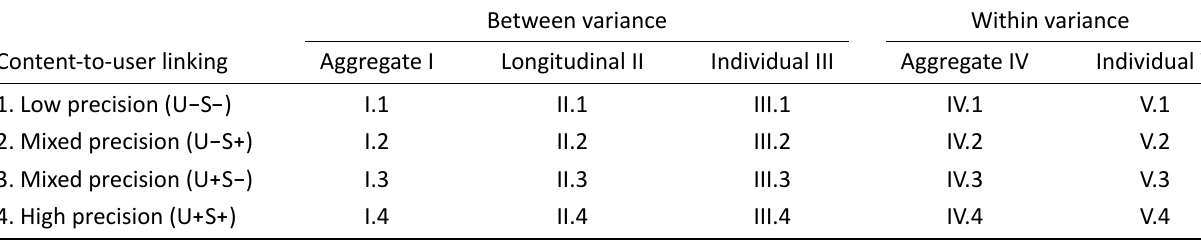
Table 1. Overview of all 20 analytical